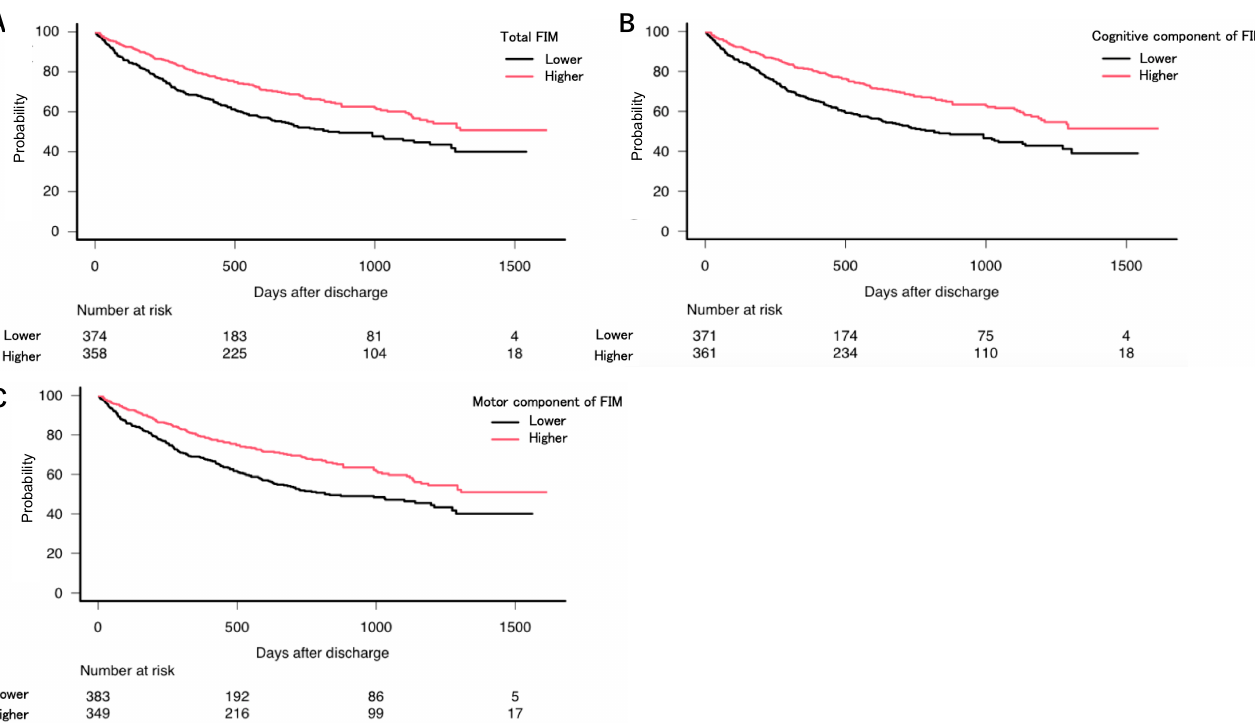
Figure 2. Kaplan–Meier curves showing the probability of non-readmission after discharge. Graphs are presented for total FIM ( A ) and cognitive ( B ) and motor ( C ) components of FIM.